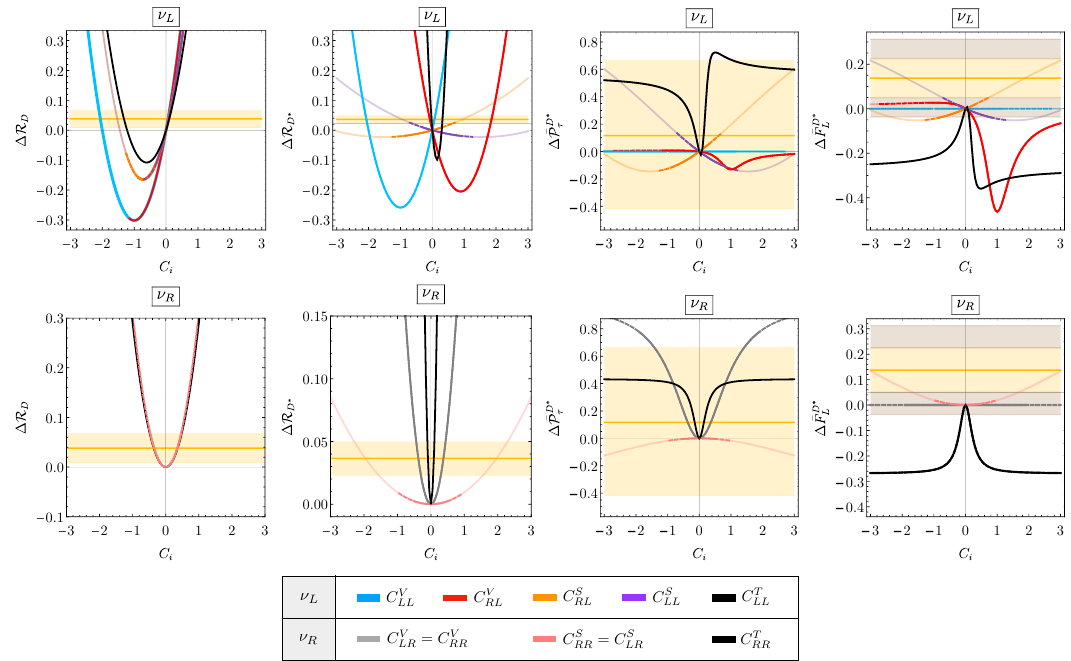
Figure 2 . Individual contributions of the Wilson coe(cid:14)cients involving LHNs (upper panels) and RHNs (lower panels). The solid (dashed) lines show the parameter space allowed by the constraint B ( B c ! (cid:28) (cid:22) (cid:23) ) < 10% (30%), whereas the fainted lines show the predictions without taking into account this